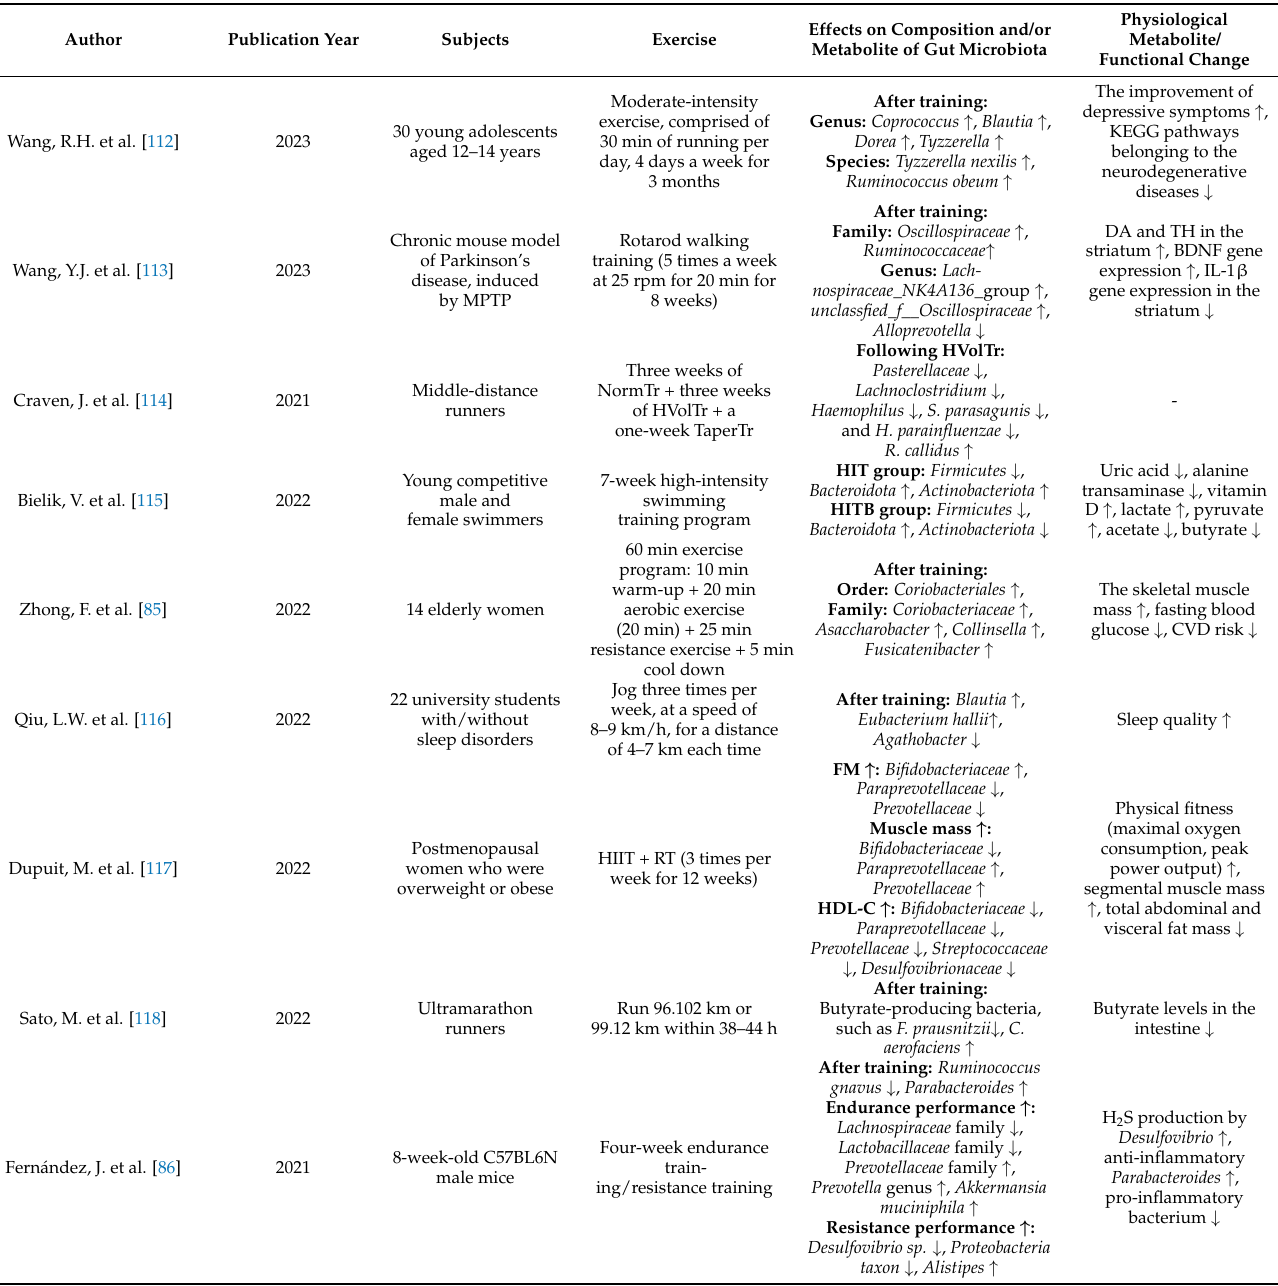
Table 7. Longitudinal studies investigating the effects of exercise on the gut